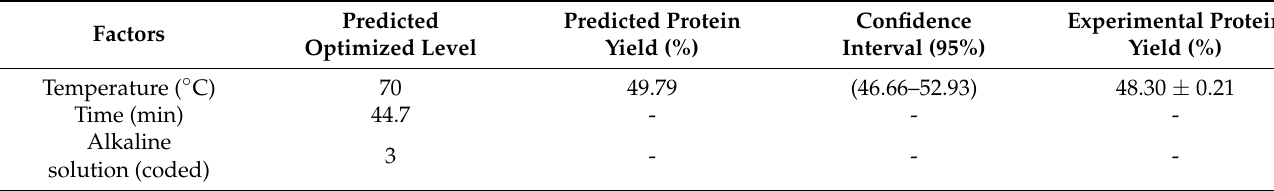
Table 6. Multiple response prediction.